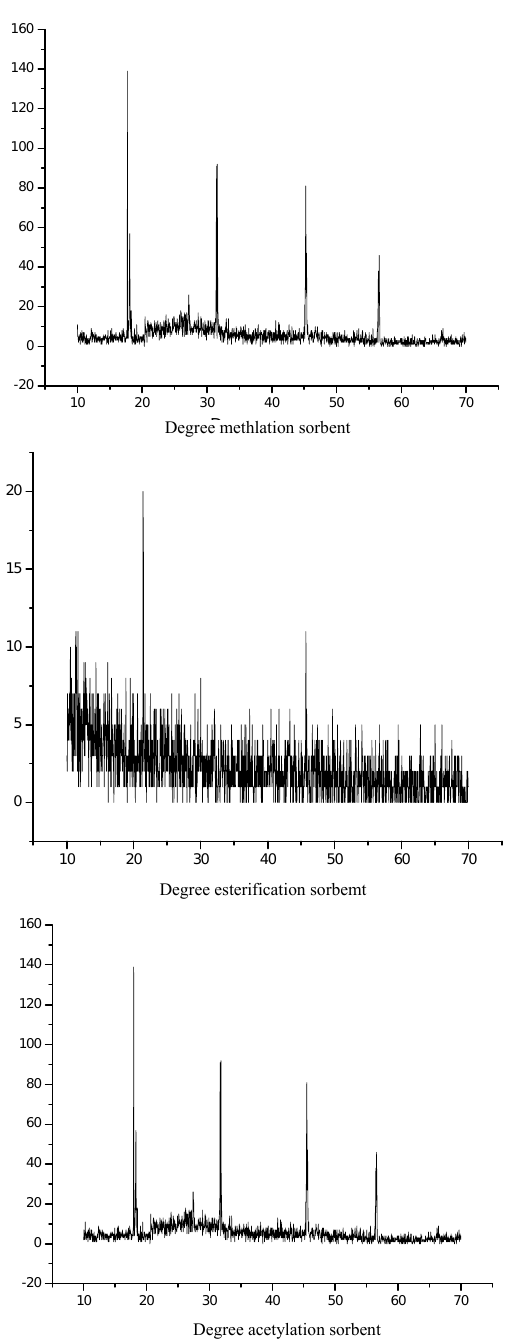
Figure 6. XRD diagrams of raw and chemically modified